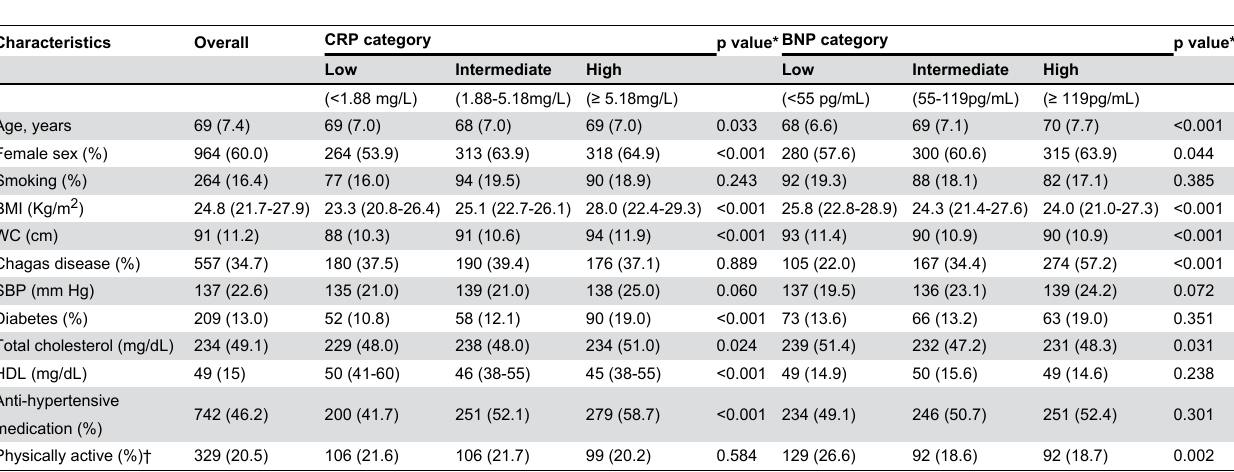
Table 1. Characteristics of overall participants at baseline, and comparison according to the tertiles of C-reactive protein and B-type natriuretic